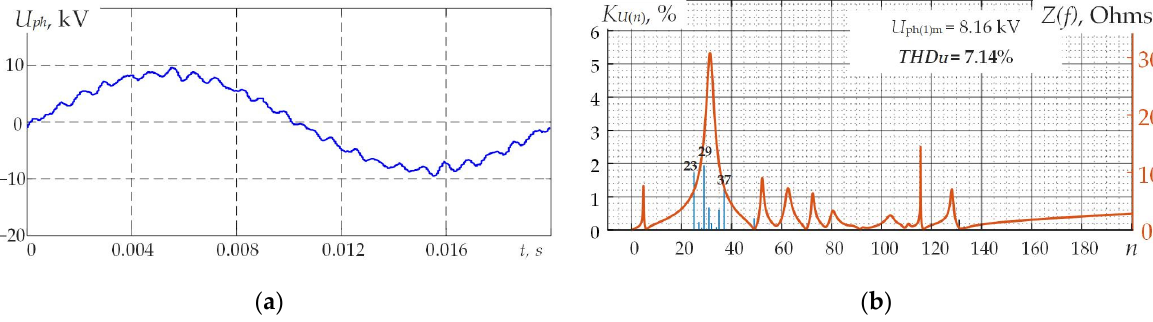
Figure 15. The instant values of phase voltage in 10 kV buses of MSDS ( a ) and their harmonic spectrum and the frequency response of the grid ( b ).